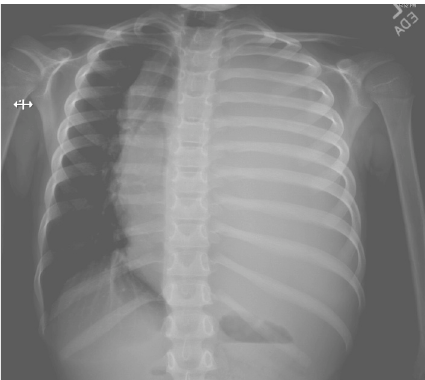
Figure 1: Chest radiograph with complete left-sided pleural ef- fusion with a resultant mass effect and significant deviation of the mediastinum to the right.